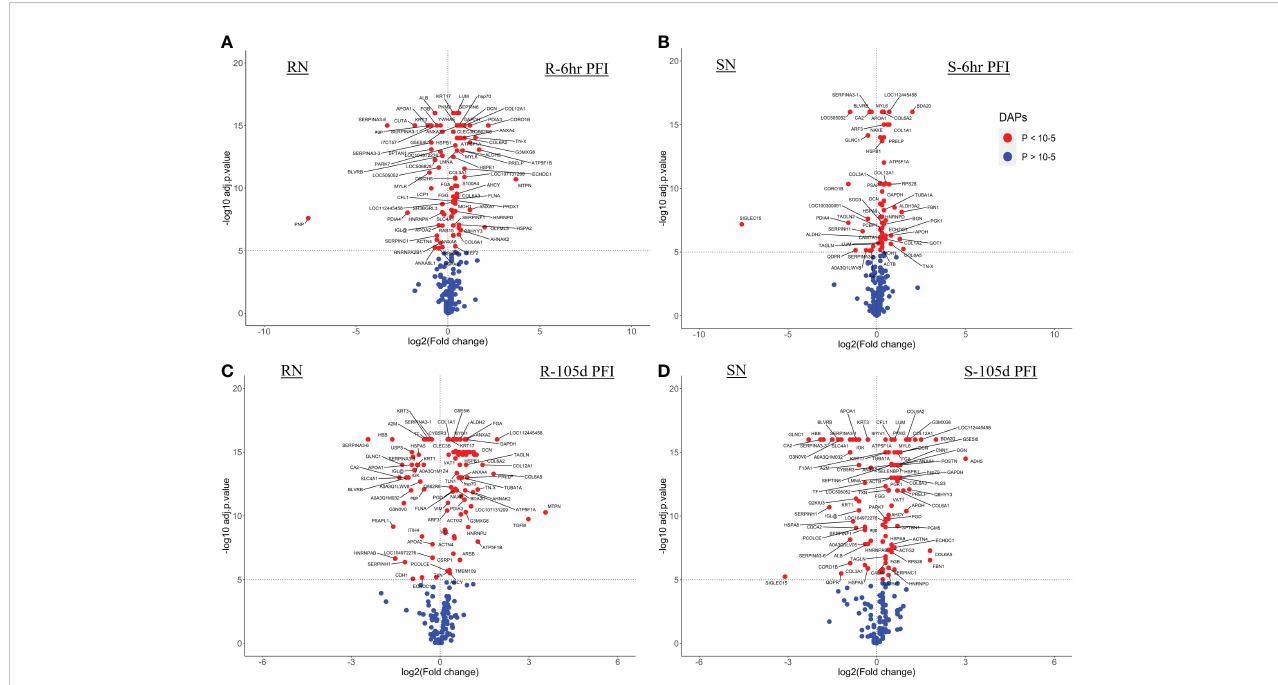
FIGURE 6 Volcano plots illustrating the differentially abundant proteins in skin samples from tick-resistant and susceptible naïve cattle in response to early (6h post- fi rst infestation) and prolonged (105d PFI) tick infestation. DA proteins in (A) resistant naïve compared to early exposure (RN vs R-6h PFI) samples from resistant cattle; (B) susceptible naïve compared to early exposure (SN vs S-6h PFI) samples from susceptible cattle; (C) resistant naïve compared to prolonged exposure (RN vs R-105d PFI) samples from resistant cattle; and (D) susceptible naïve compared to prolonged exposure (SN vs S-105d PFI) samples from susceptible cattle. Coloured dots represent proteins signi fi cantly different in abundance (P < 10 -5 ). Red, signi fi cantly different in abundance (P < 10 -5 ). Blue, not signi fi cantly different in abundance (P > 10 -5